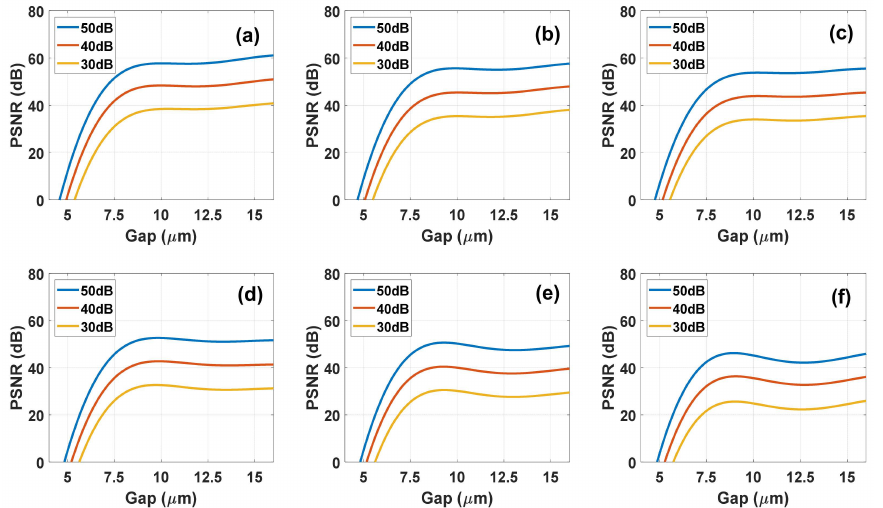
Figure 12. Simulation results of the reconstruction quality measured in PSNR, as function of the NLC E7 gap at different SNR as indicated for each curve values and different number of Voltages: ( a ) 56; ( b ) 28; ( c ) 19; ( d ) 14; ( e ) 12; ( f ) 10.